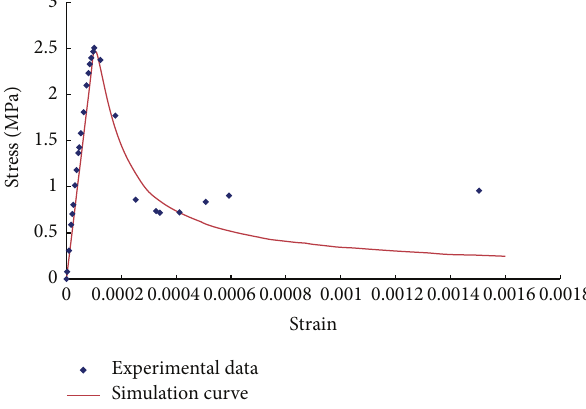
Figure 7: Comparison of stress-strain relationship between numer- ical simulation and experimental tests for specimen A3.